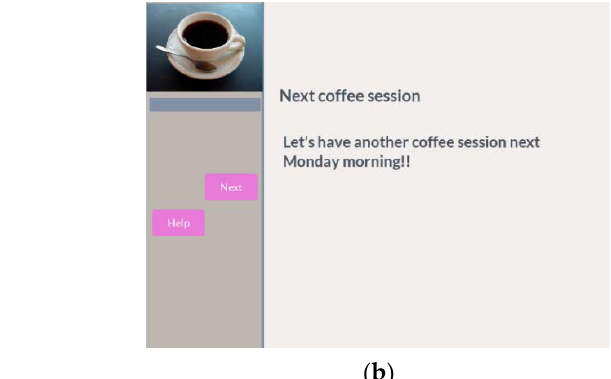
Figure 16. Mock-up for motivational day agenda. The motivational day agenda can detect the next milestones and produce a motiva- tional message each time any of the following is achieved: •